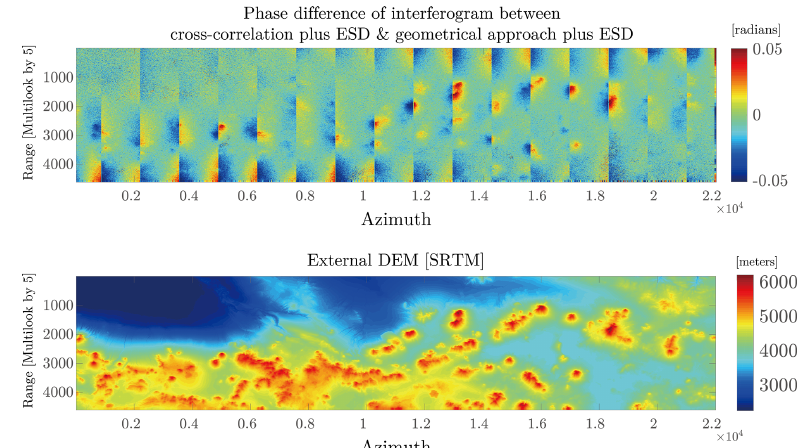
Figure 3. The comparison between the proposed approach and the established approach in terms of interferogram for the same test site shown in Figure 2. ( Top ) the interferogram phase difference between the proposed approach and the established approach; ( Bottom ) the DEM from SRTM for the